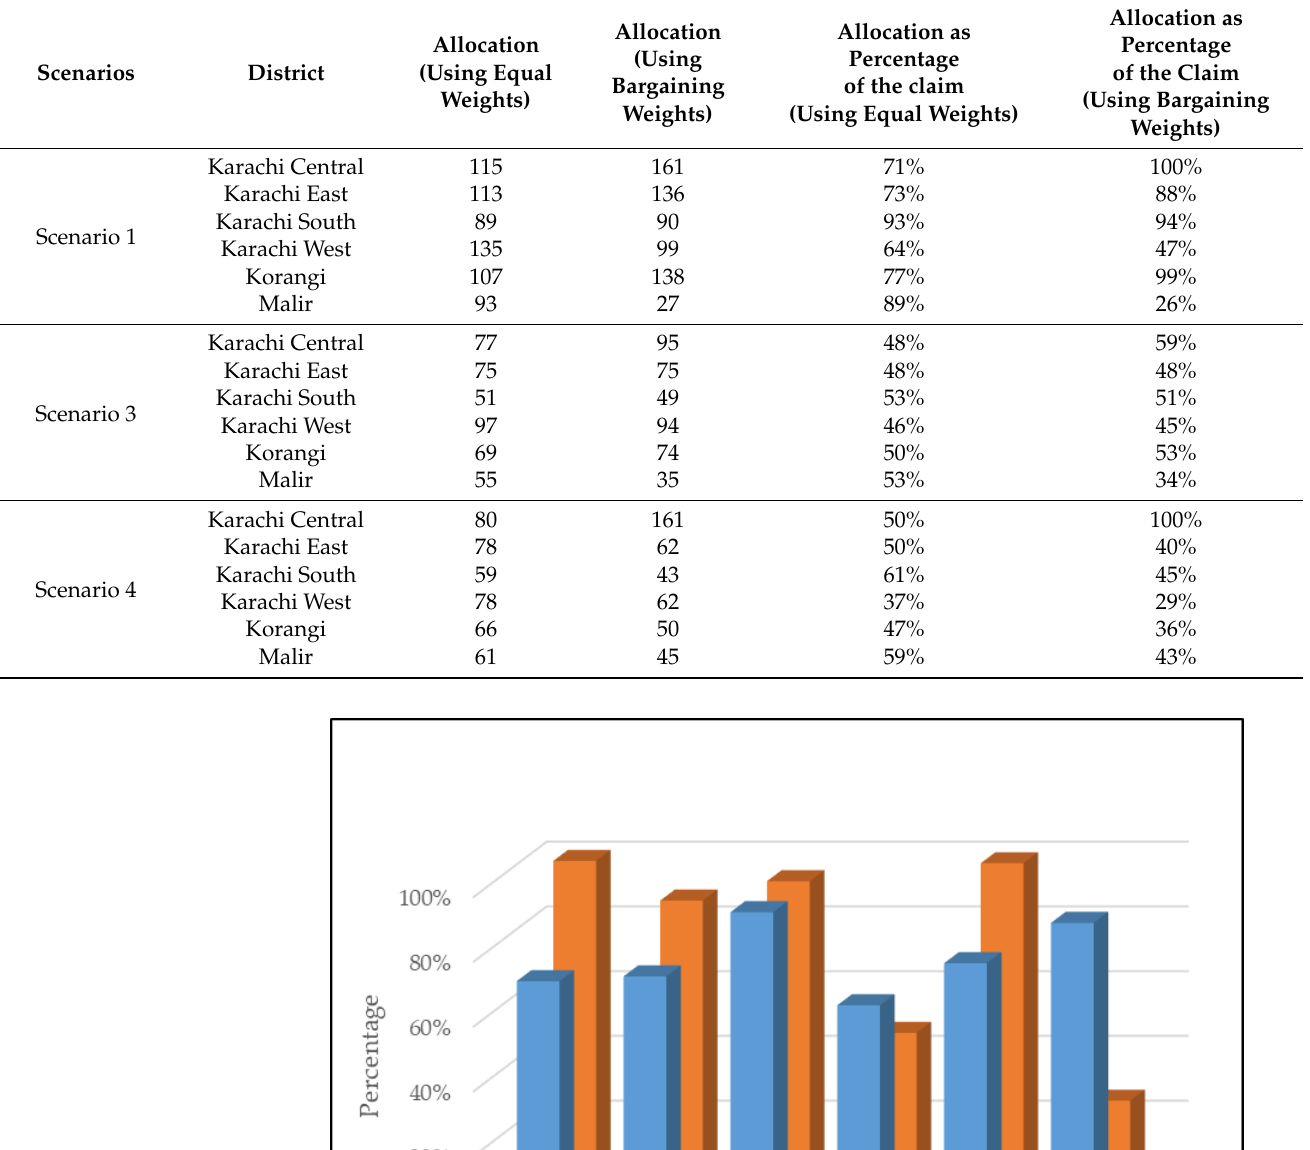
Table 6. Results for all scenarios using homogenous and heterogenous weights.